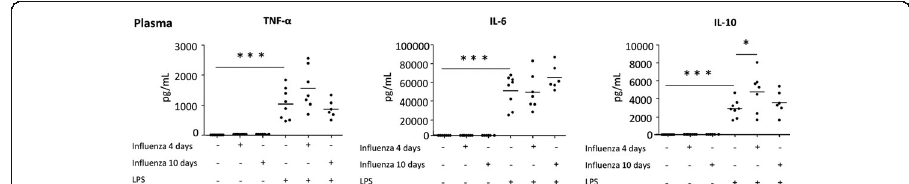
Fig. 2 Plasma levels of TNF- α , IL-6, and IL-10 in mice that received influenza/mock followed by LPS/NaCl 4 or 10 days later. Data are presented as scatter-dot plots with horizontal lines indicating the mean value. * p < 0.05, ** p < 0.01, *** p < 0.001 (calculated by unpaired Student ’ s t tests)